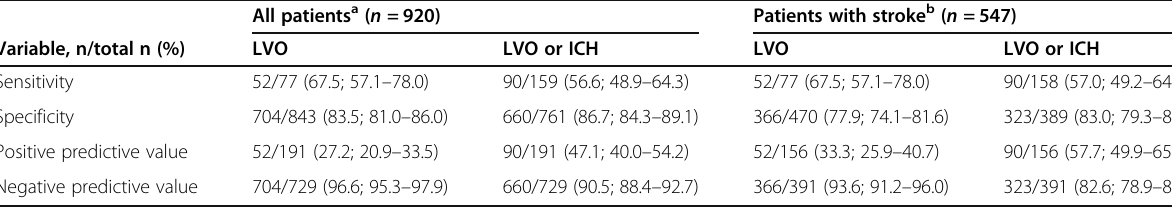
Table 3 Performance of the LAMS tool (cut-off value, ≥ 4) in identification of LVO and LVO or ICH All patients a ( n = 920) Patients with stroke b ( n = 547)